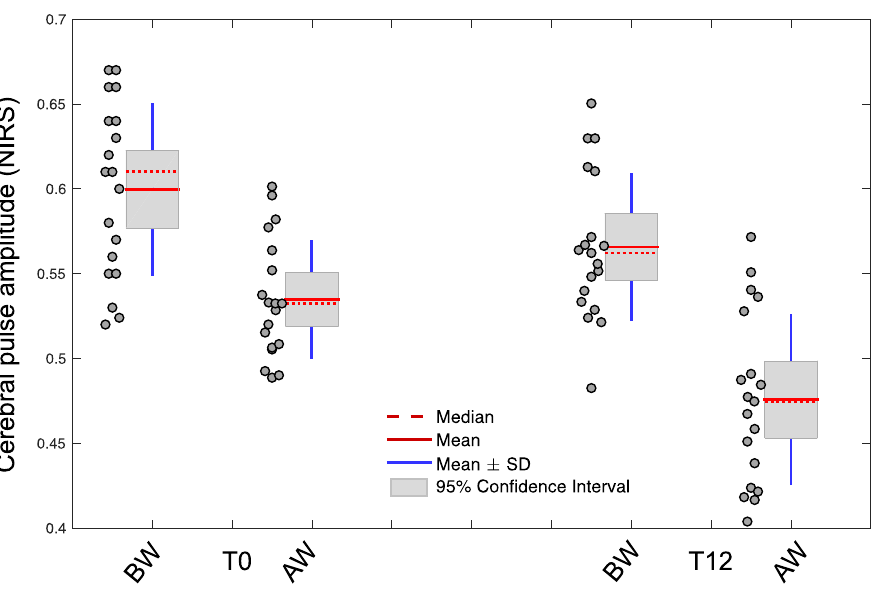
Figure 2. The boxplots of global cerebral pulse amplitude (averaged across all the channels) for before walking at baseline (T0) and after 12 months (T12). BW, AW and SD are abbreviations for standing rest before walking, standing rest after walking and standard deviation respectively.